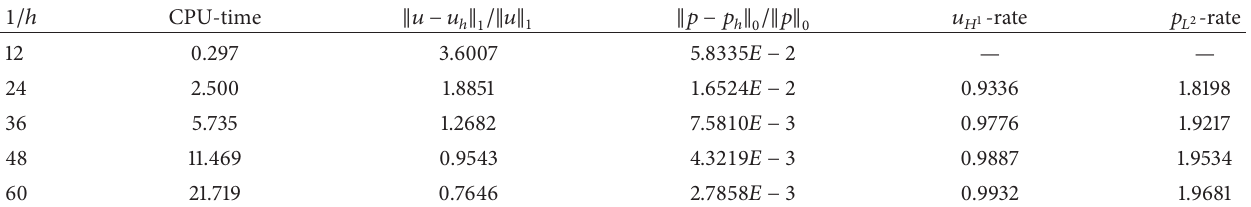
Table 5: Results got from the local Gauss integration method with the nonconforming element with ] = 1.0𝑒 − 4 , 𝛼 = 1.0𝑒 − 4 , and 𝑟 = 3